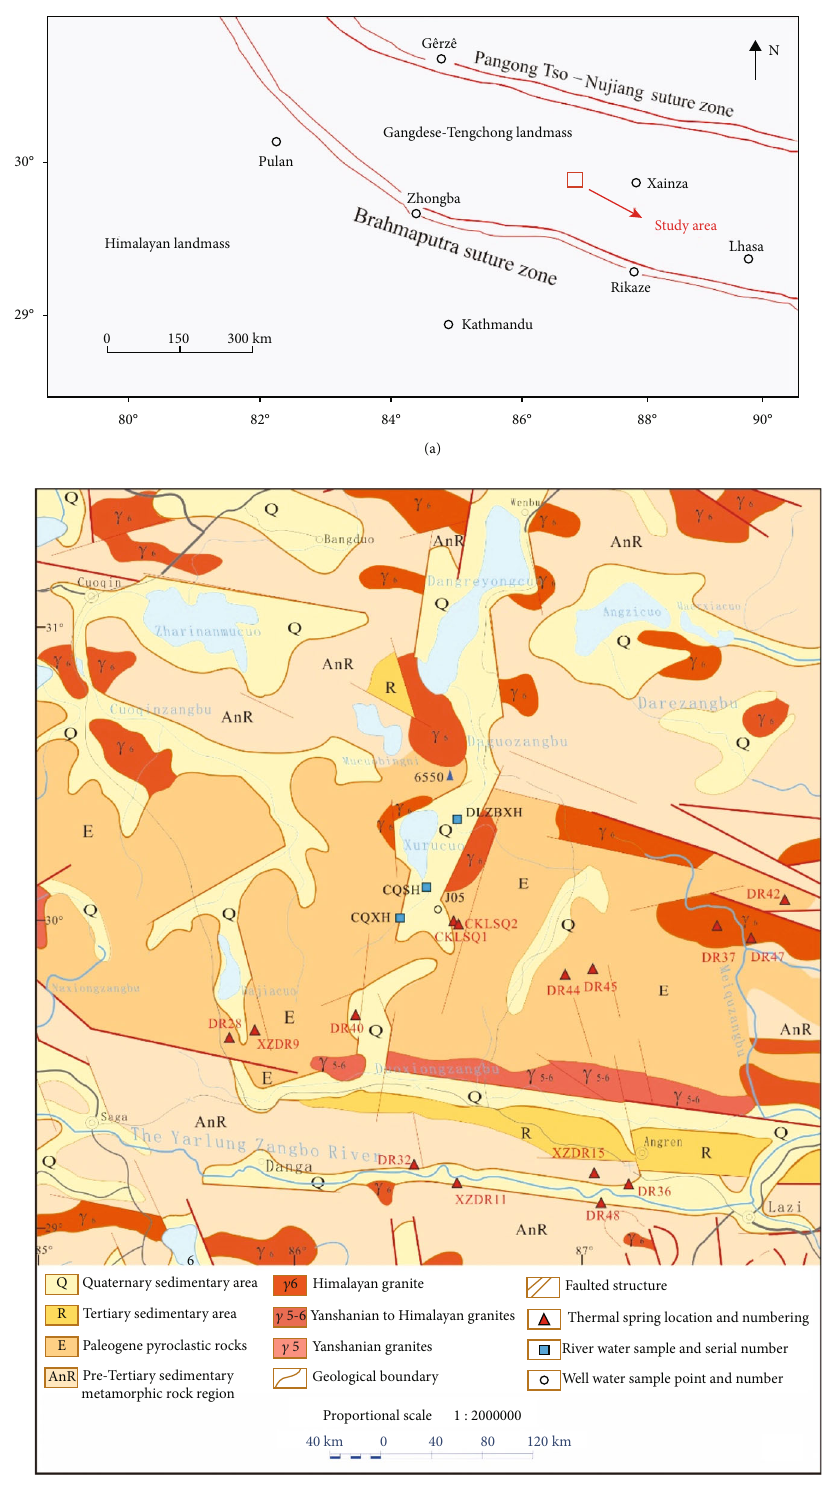
Figure 1: Geodetic structure location map and geological sketch of the study